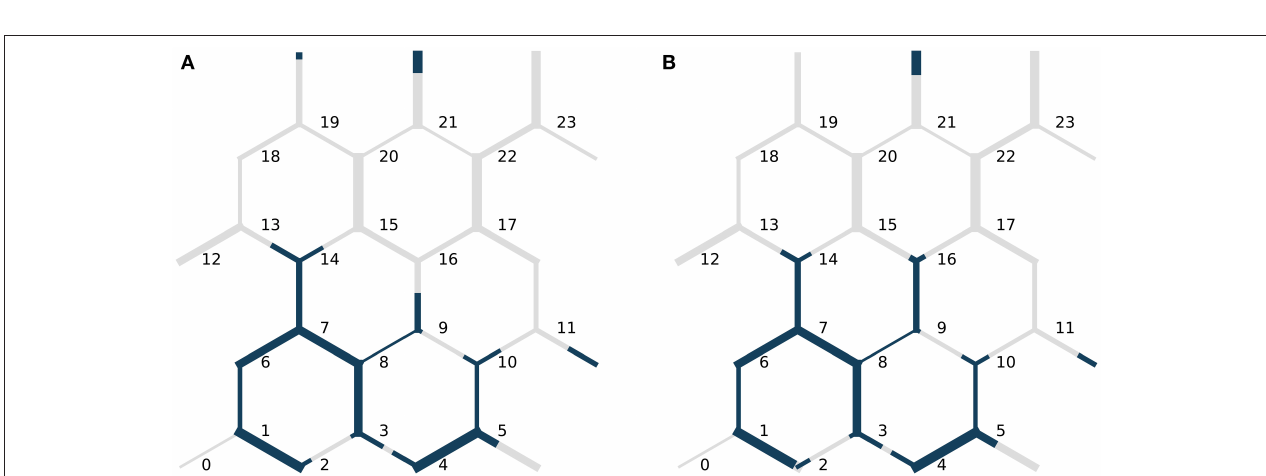
FIGURE 9 | Fluid distribution in the Haines jump case (A) at t = 0 . 23s and (B) at t = 0 . 27s , before and after the Haines jump. During the jump, non-wetting fluid breaks-through the link connecting nodes 9 and 16 and invades node 16. Also, non-wetting fluid in other links at the downstream end of the moving ganglion retracts. This is seen e.g. in the links downstream of nodes 10 and 14. The link radii are not drawn to scale with the link lengths. Node indices are indicated in black.